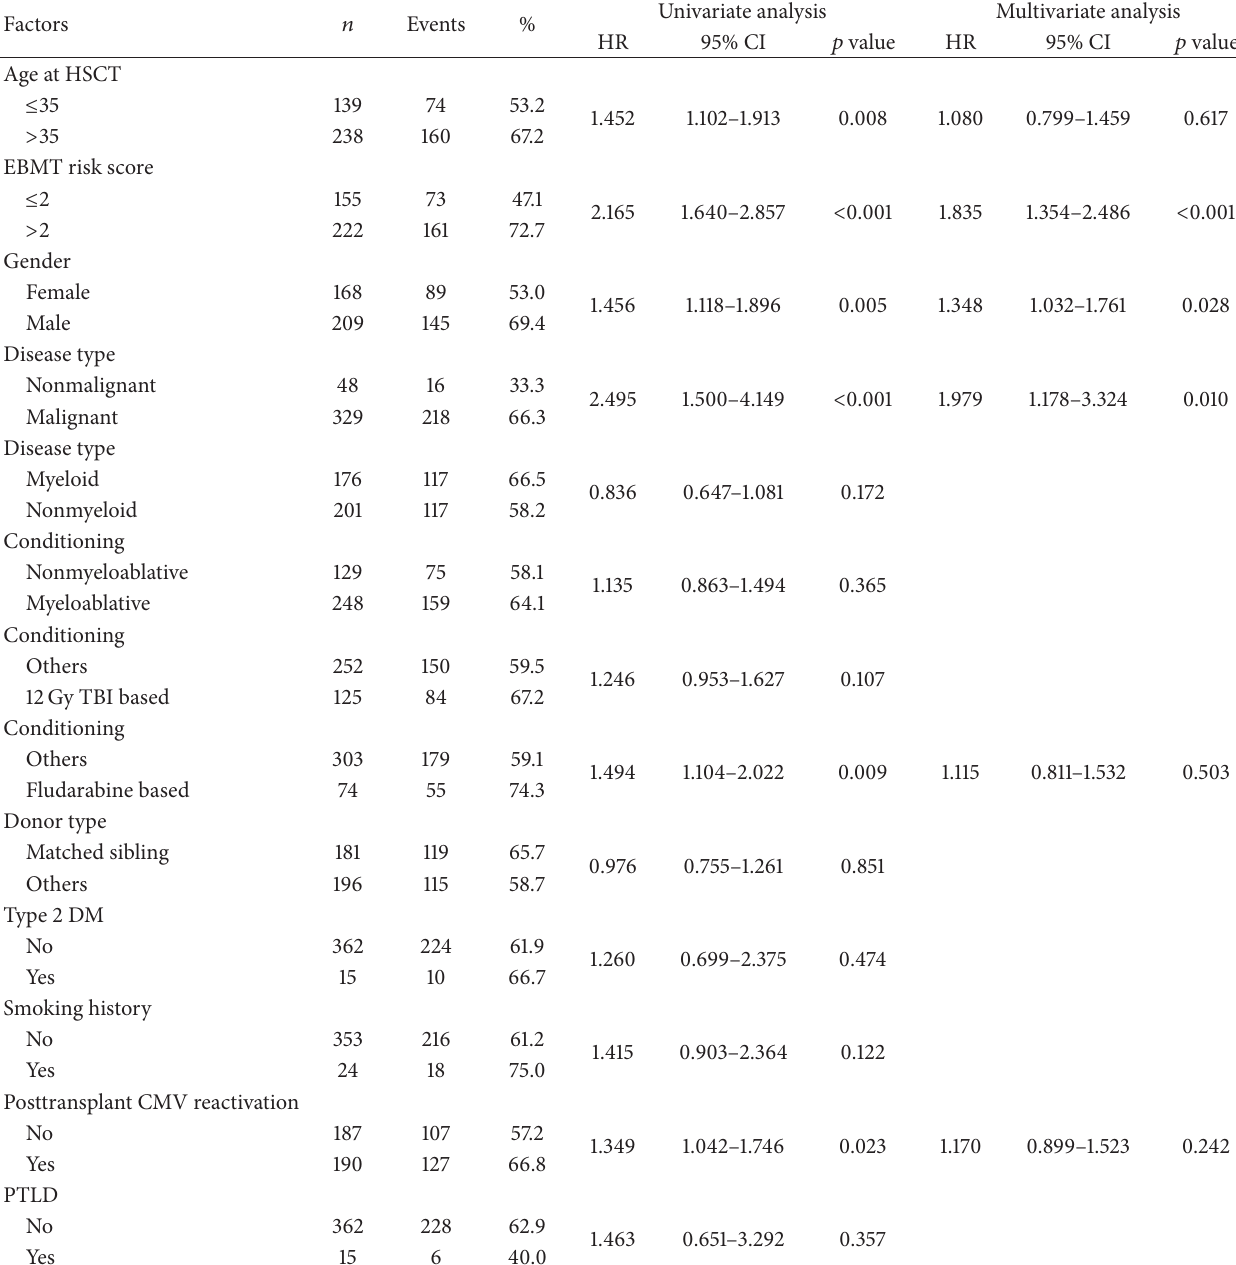
Table 3: Prognostic factors for 2-year GRFS after adult allogeneic